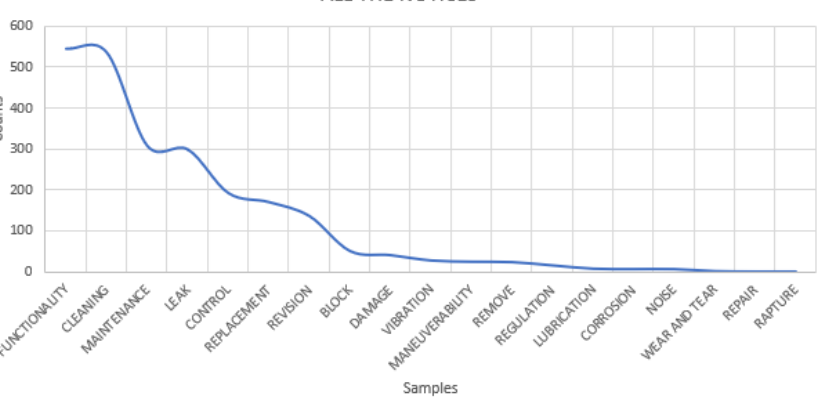
Figure 5. Frequency distribution of the fault category with respect to the notices of all the